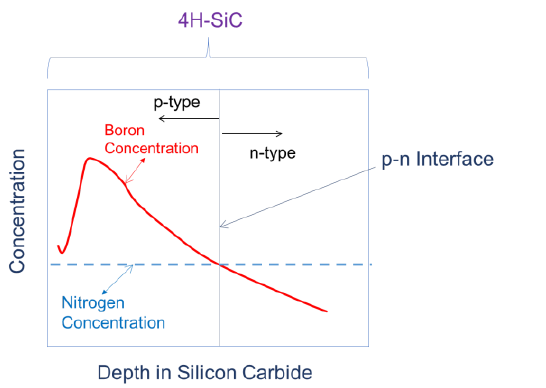
Fig. 1. Schematic representation of the regions of a p-n diode formed by diffusing boron into n-type SiC.